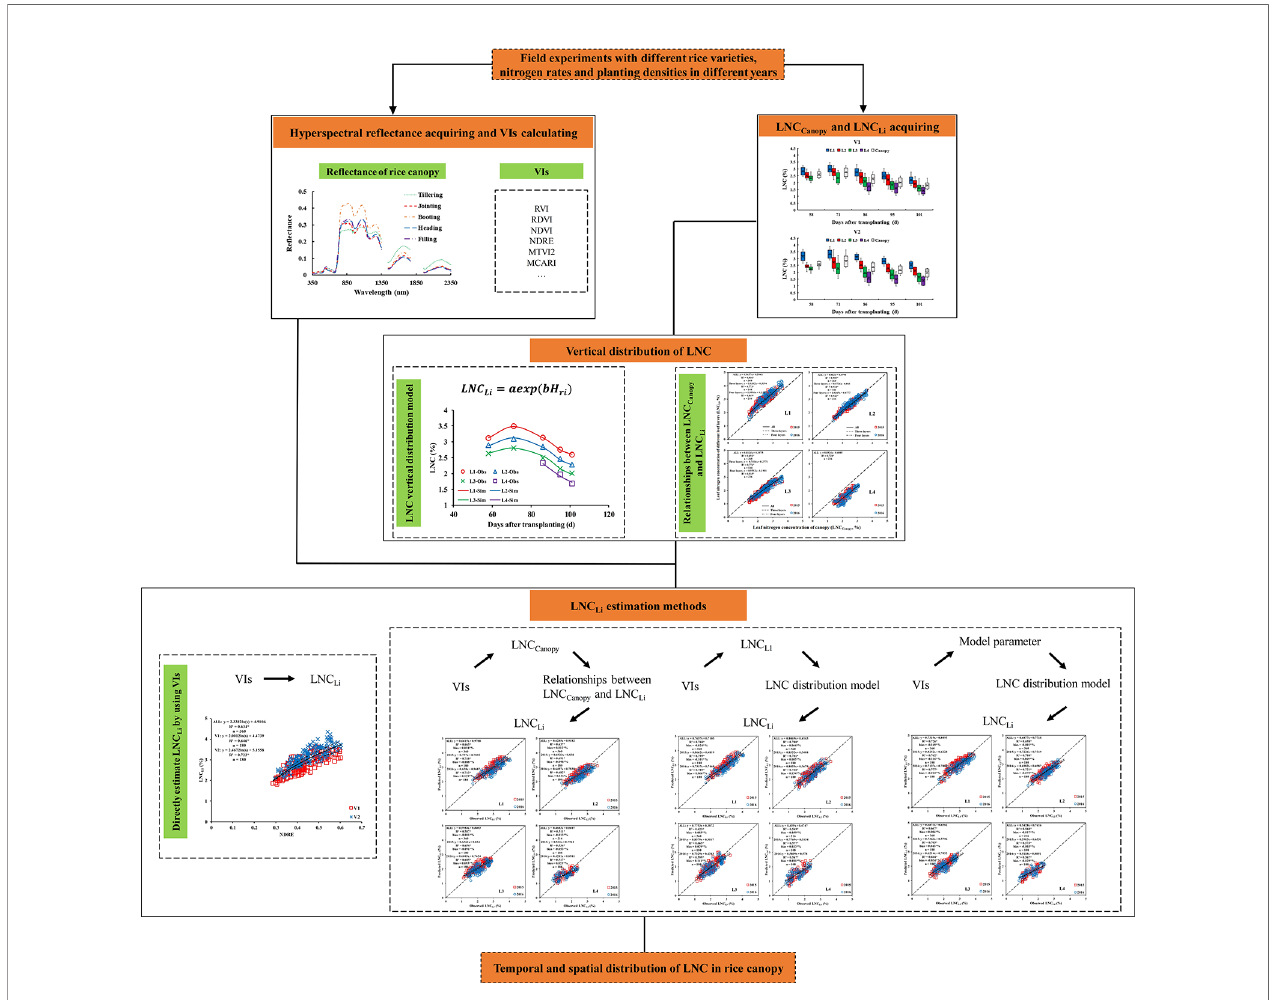
FIGURE 1 | Flowchat for establishing the optimal LNC Li estimation